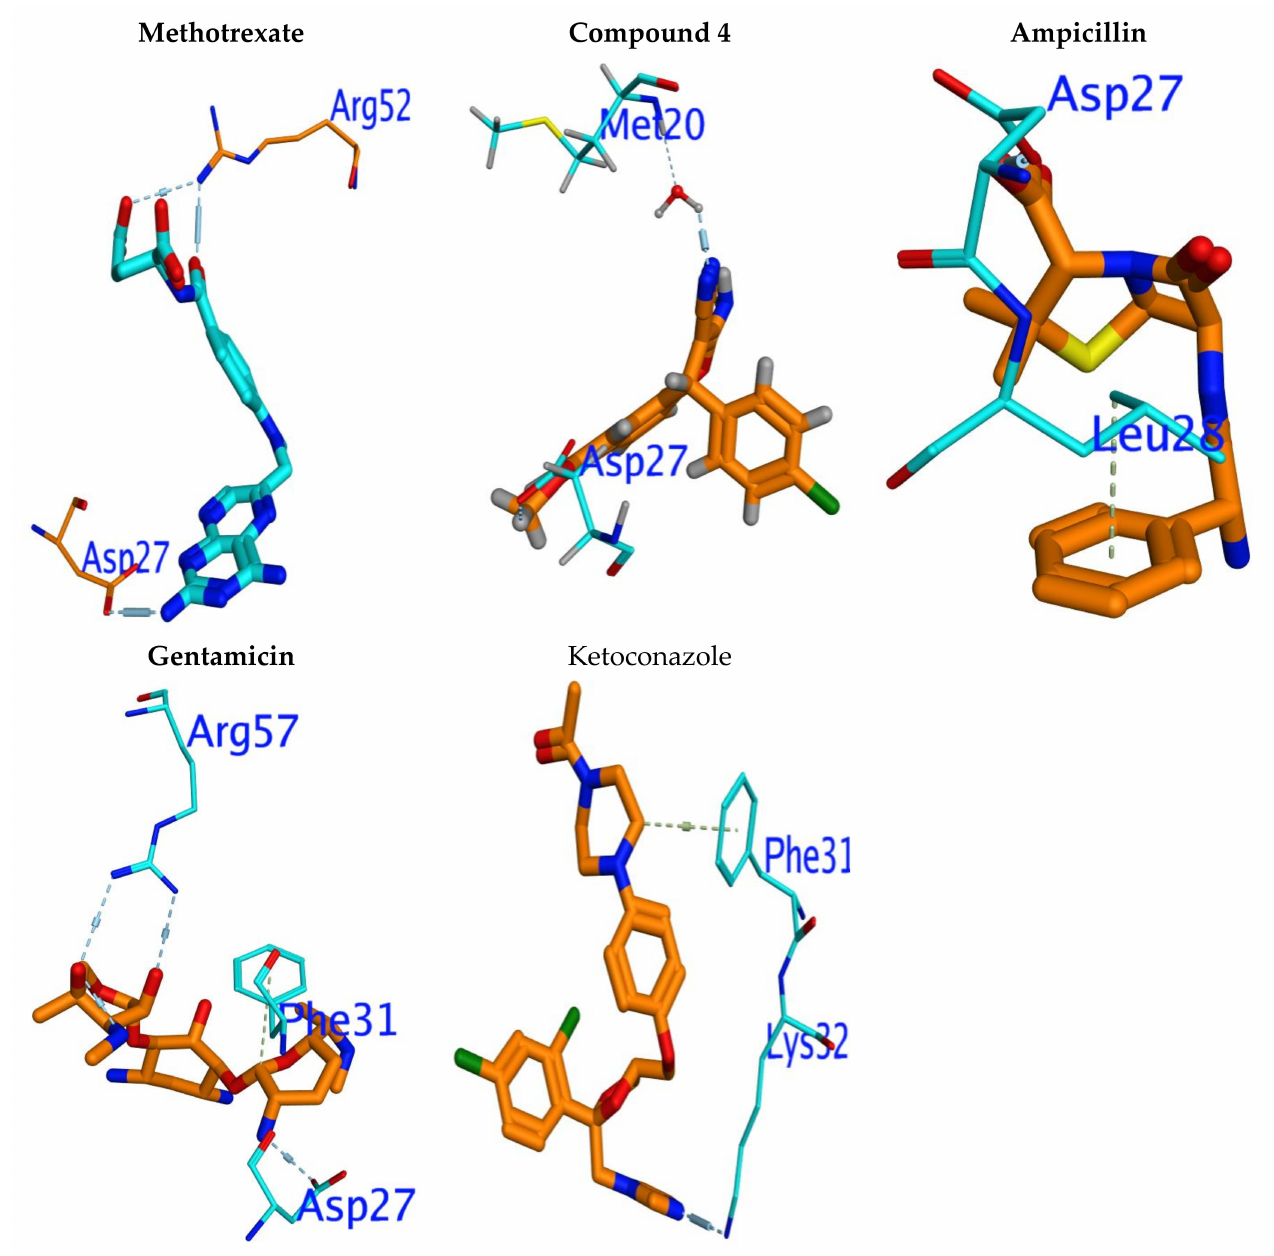
Figure 3. Predicted binding mode of compounds 4 and reference inhibitors into 4DFR H-bondings represented in blue lines, while π - π bond in green